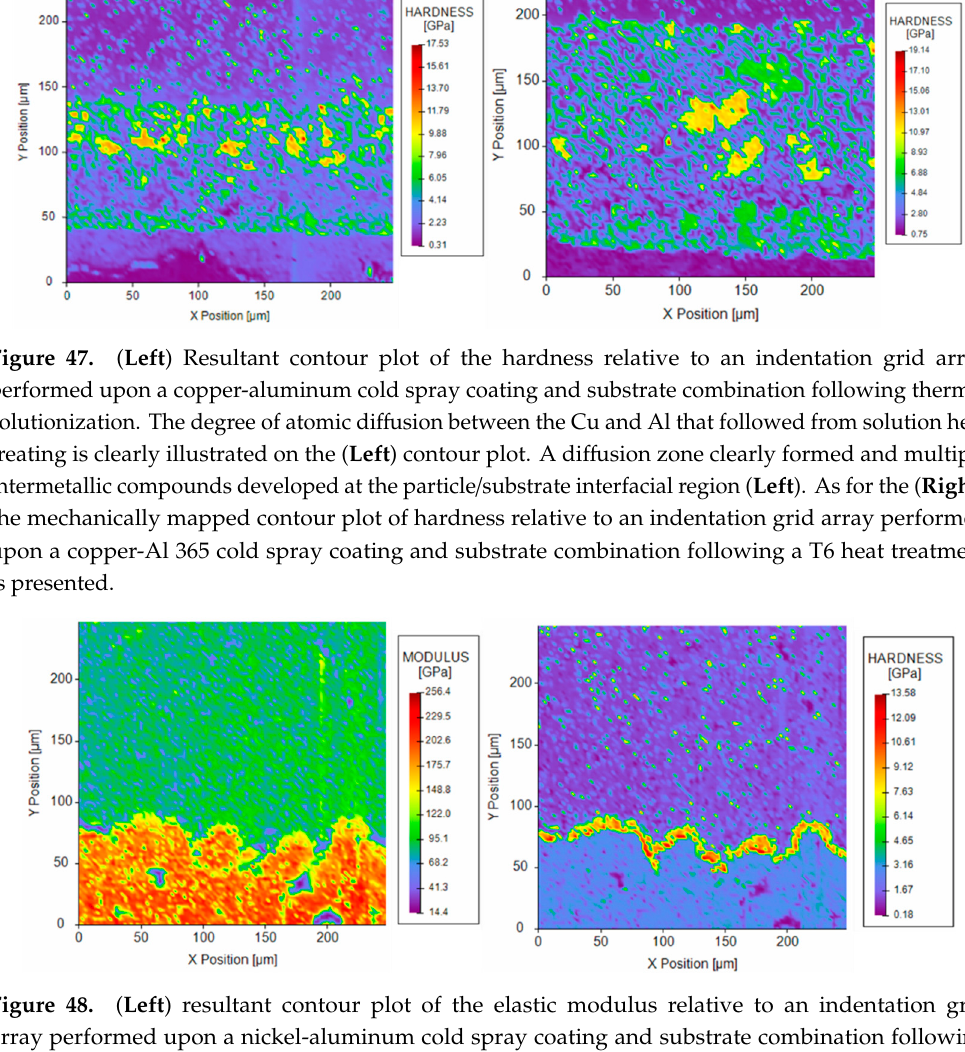
Figure 48. ( Left ) resultant contour plot of the elastic modulus relative to an indentation grid array performed upon a nickel-aluminum cold spray coating and substrate combination following solutionization. Much less di ff usion occurred in comparison with the Cu-Al combination; however, the particle / substrate interfacial region precipitated a rich layer of (Al,Ni) precipitates of extremely high hardness relative to pure nickel and the aluminum substrate ( Right ). As for the ( Right ), the mechanically mapped contour plot of hardness relative to an indentation grid array performed upon a Ni-Al 365 cold spray coating and substrate combination following a solution heat treatment is